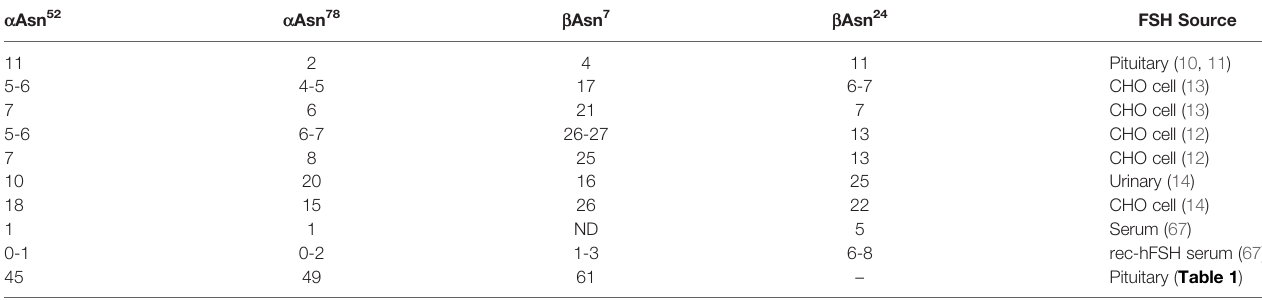
TABLE 3 | Oligosaccharides detected at FSH glycosylation sites in site-speci fi c glycosylation